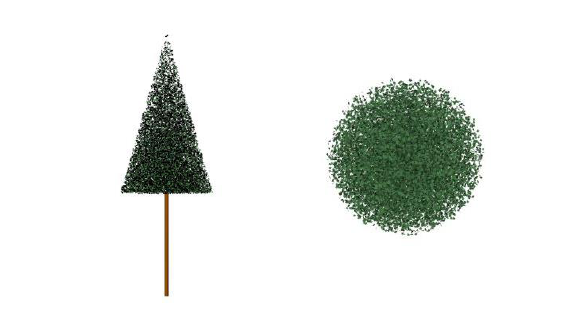
Figure 1 . The single tree model is constructed by LESS, with the front view on the left and the top view on the right.